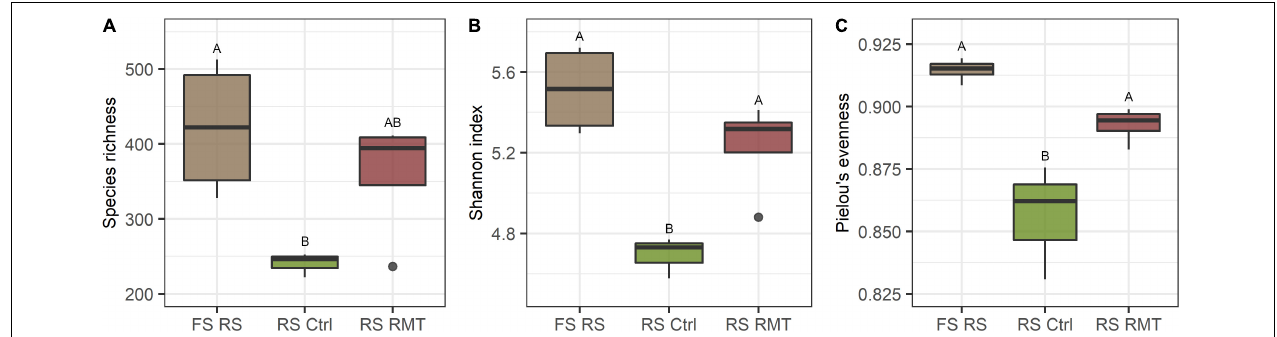
FIGURE 8 | Comparison of microbial diversity between barley rhizosphere from field soil, rhizosphere microbiome transplant, and control treatments. (A) Species richness, (B) Shannon index, and (C) Pielou’s evenness of barley rhizosphere (RS) from field soil (FS) that served as rhizosphere microbiome transplant (RMT), additionally to rhizosphere from barley grown in potting soil treated with RMT or the control (Ctrl). Different letters indicate significant differences (Tukey’s test; p ≤ 0.05).